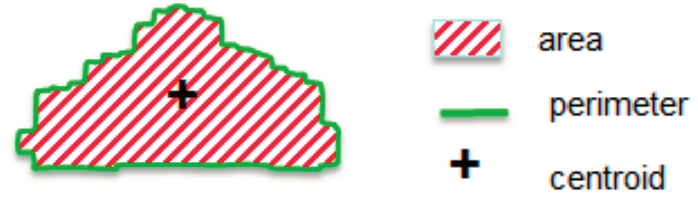
Figure 11. Geometric feature